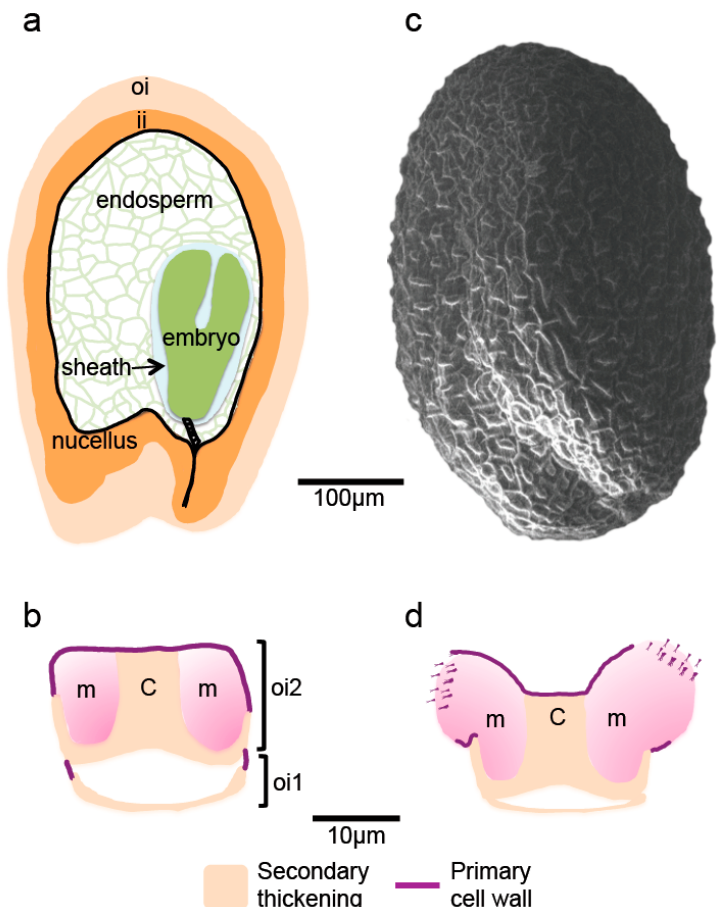
Figure 1. Structure of Arabidopsis seed and outer integument cells. Schematic representation of ( a ) the different tissues in a transverse section of a developing seed at the linear cotyledon stage when the endosperm has cellularized and ( b ) transverse section of fully differentiated outer integument cells from early maturation stage seeds. The cells have undergone programmed cell death, following the accumulation of mucilage polysaccharides and/or secondary thickening of the innermost walls. ( c ) Scanning electron micrograph of the reticulate surface of a mature dry seed. ( d ) Schematic representation of the localized fragmentation of the primary wall on imbibition that allows mucilage release from the epidermal cells of the seed coat. C, columella, m, mucilage polysaccharides, oi, outer integuments, ii inner integuments and oi1 and oi2, sub-epidermal and epidermal cells of the outer integument, respectively.